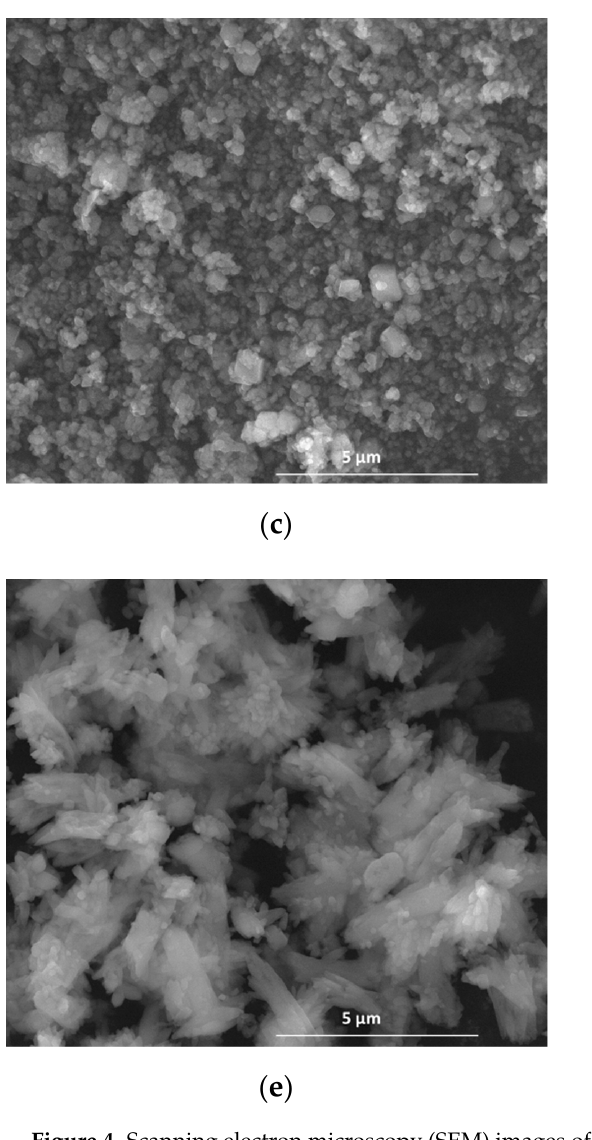
Figure 4. Scanning electron microscopy ( SEM) images of dried powders CC0.5 ( a , b ), CC3.7 ( c , d ) and CC7.4 ( e , f ).